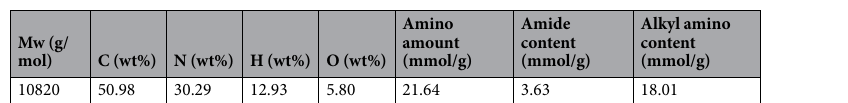
Table 1. Molecular weight and amino content of HBP-NH 2 where the amide content (mmol/g) of HBP-NH 2 was calculated from the oxygen mole content, alkyl amino content of HBP-NH 2 was calculated by subtracting the amide content from total amino amount.